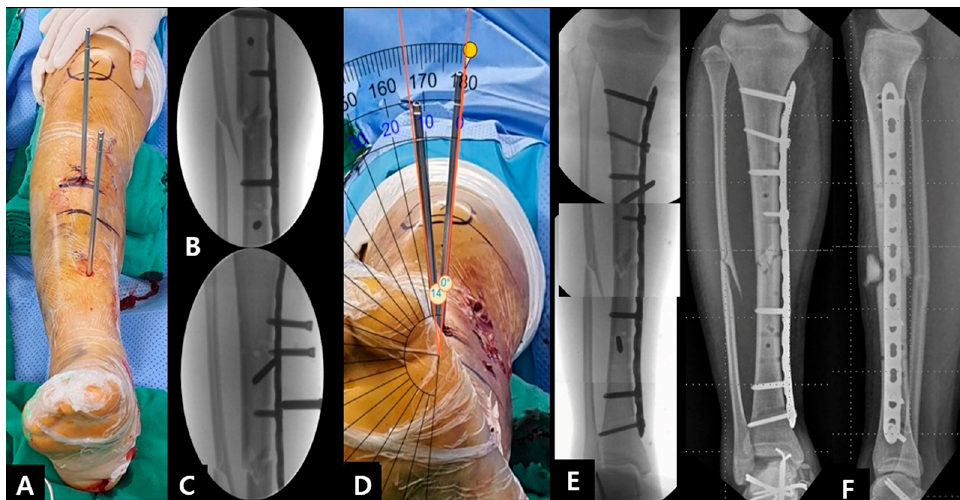
rotation compared with the noninjured side.